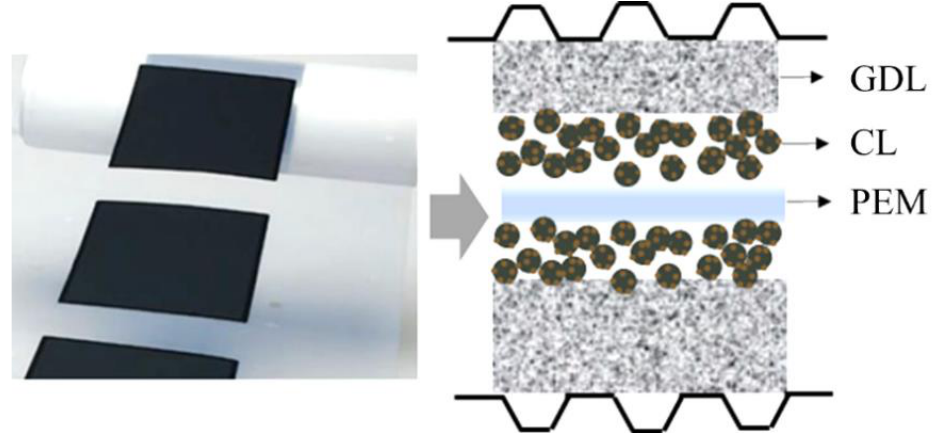
Figure 4. Schematic diagram of the MEA structure.